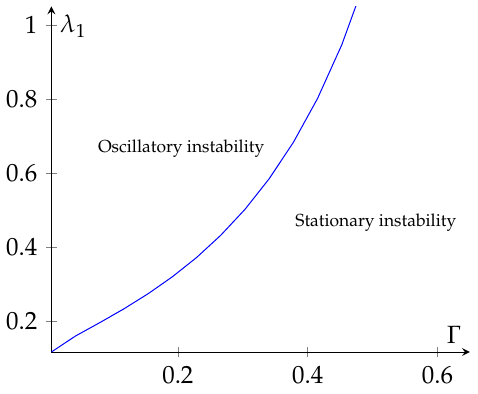
Figure 2. Elasticity levels λ 1 versus the viscosity ratio Γ defining the crossover between stationary and oscillatory primary bifurcations. Results were obtained with the single-term Galerkin expansion (25) and